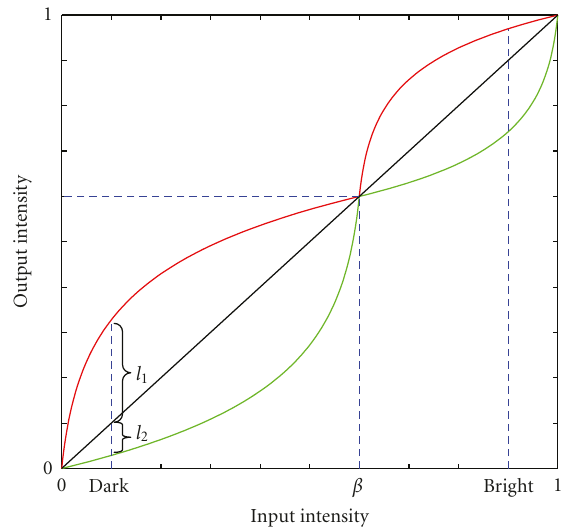
Figure 7: Our adaptive piecewise mapping function. It consists of two segments, each of which adapts from the red curve to the green curve